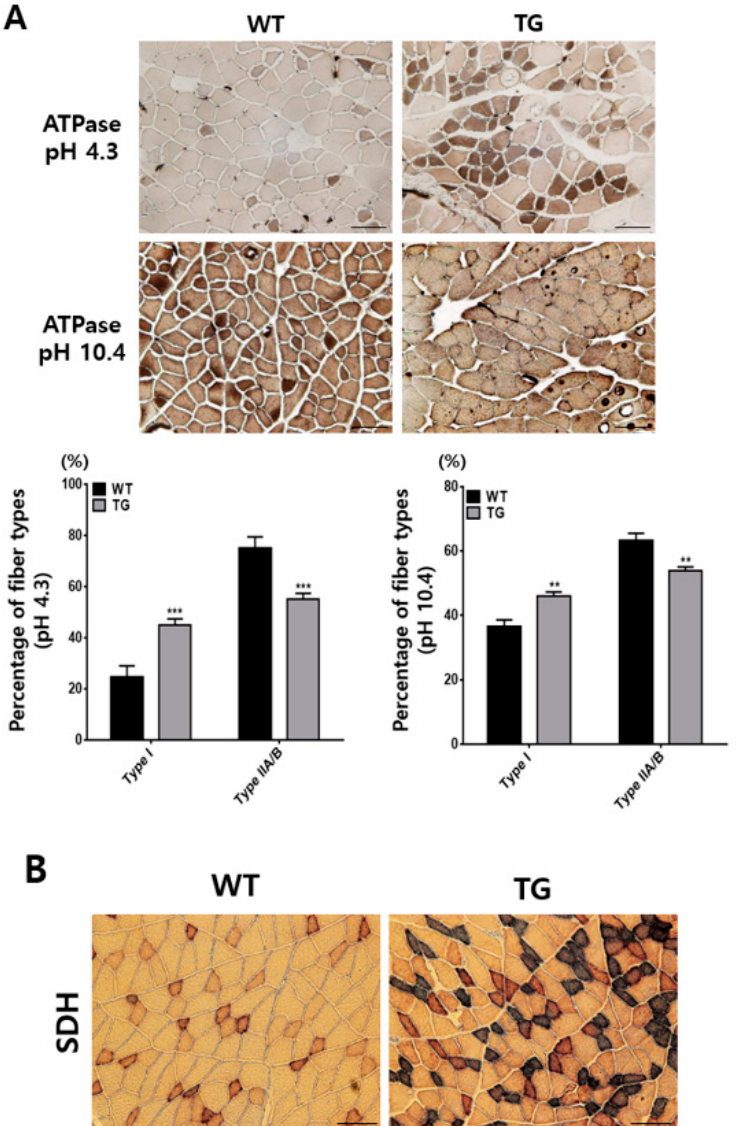
Figure 5. Comparisons of quadriceps muscle type in mice. ( A ) ATPase staining and morphometric analysis of quadriceps in WT and TG mice. When pH is 4.3, type 1 fibers show brown and type 2 fibers show a beige/white color: type I fibers, slow muscle type; WT vs. TG, 24.8% vs. 45%, whereas type II fibers, fast muscle type; WT vs. TG, 75.2% vs. 55%. When pH is 10.4 data, type 1 fibers show beige/white and type 2 fibers show a brown/black color: type I fibers, slow muscle type; WT vs. TG, 36.6% vs. 46.1%, whereas type II fibers, fast muscle type; WT vs. TG, 63.4% vs. 58.9%. ( B ) Mitochondria oxidation analysis by succinate dehydrogenase (SDH) staining. More mitochondrial oxidation (slow-type muscle fibers) is shown by a dark color. Data are expressed as the means ± SEM for three independent replicates and multiple t -tests were used for the statistical analysis. ** = p < 0.01 and *** = p < 0.01. The scale bar represents 100 µm.